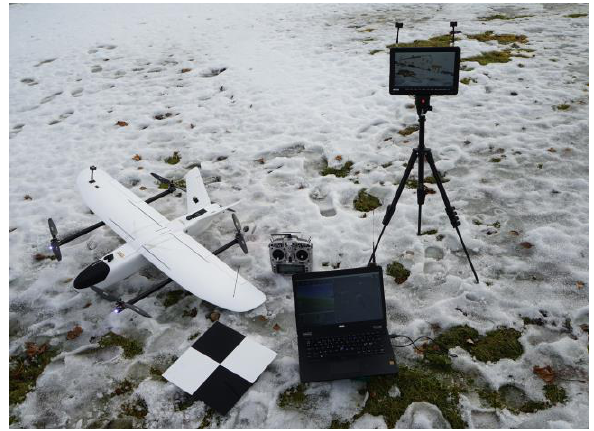
Figure 4. Overview of the equipment with ground station laptop, UAV, ground mark, remote control, and live video screen